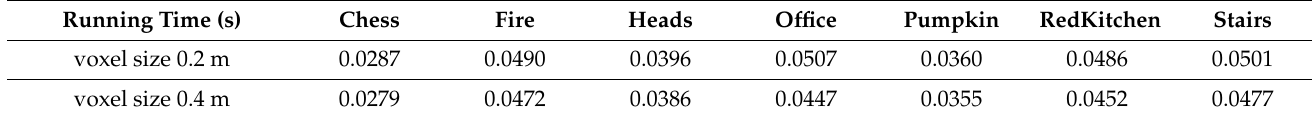
Table 6. Running time comparison after point cloud down-sampling through voxel